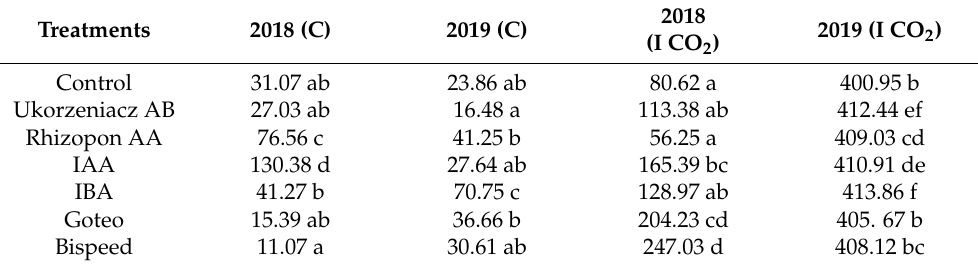
Table 7. Stomatal conductivity (C, mol H 2 O · m − 2 · s − 1 ) and internal concentration of carbon